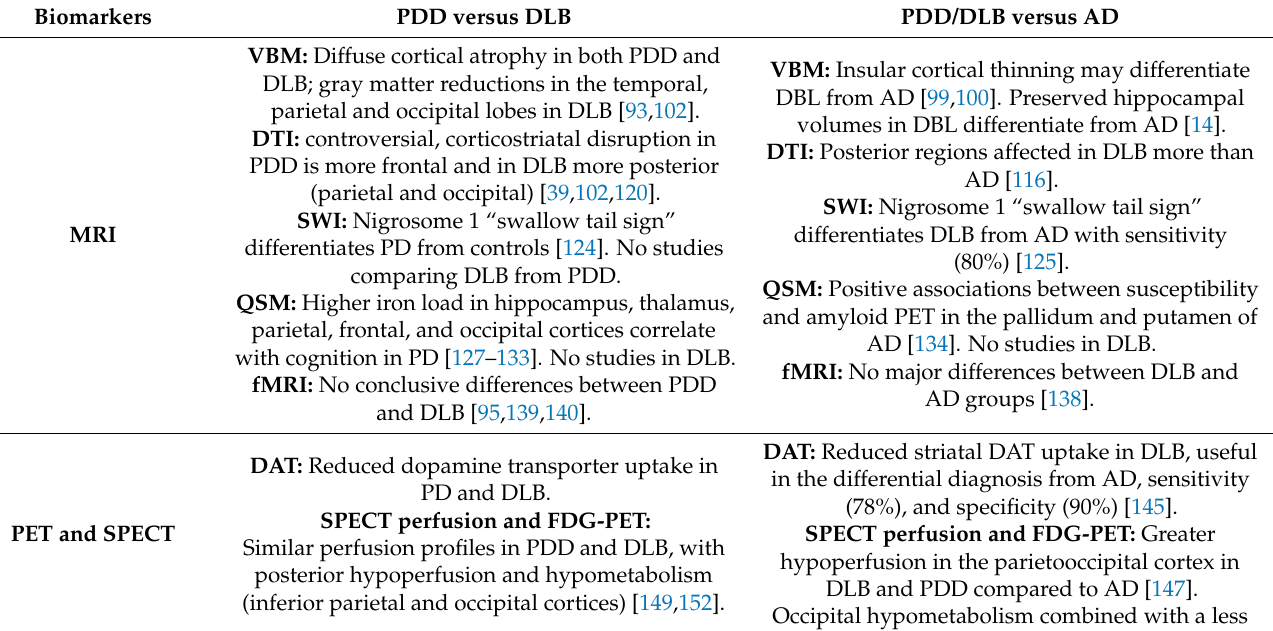
Table 3. Summary of the overlap and dissimilarities in the biomarker findings of PDD, DLB, and AD.